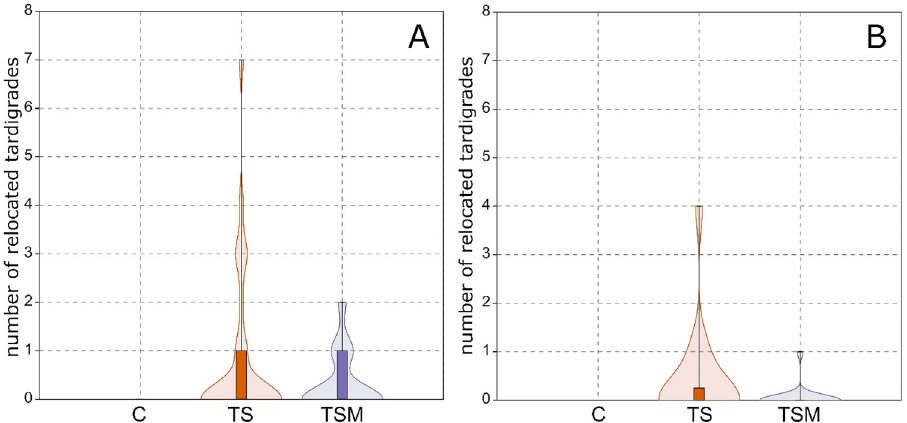
Figure 4. Violin plots with box plots showing number of tardigrades relocated for ( A ) dead and alive tardigrades transferred; ( B ) tardigrades being alive during inspection. The plot depicts data for each experimental option: T—tardigrades, TS—tardigrades with snails, TSM—tardigrades, snails and moss. Whiskers show maximum and minimum values of tardigrades relocated per sample at each option. Graphs were made with PAST 4.0 software (http:// www. nhm. uio. no/ engli sh/ resea rch/ infra struc ture/ past/).